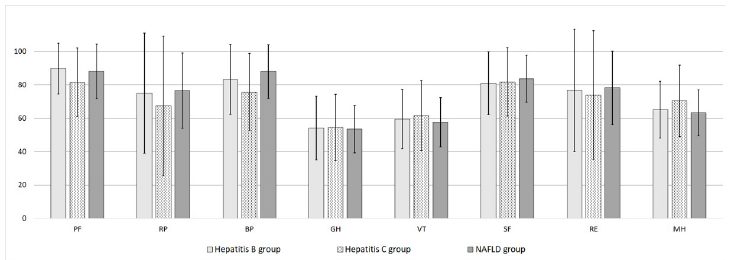
Fig 1. The eight items of SF-36 questionnaire in three patient groups (mean ± SD).